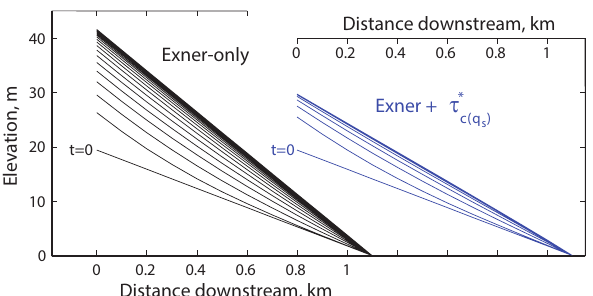
Figure 6. Profile evolution, comparing the morphodynamic re- sponses of models with and without threshold evolution. The initial = 0 . 06, upstream condition is an equilibrium channel with τ ∗ c( q s ) sediment supply q s = 1 × 10 − 3 m 2 s − 1 , and an initial equilibrium slope of 0.0147. Sediment supply is increased 5 × at t = 0. Lines are each 5 model days apart, and indicate the evolution to a new transport